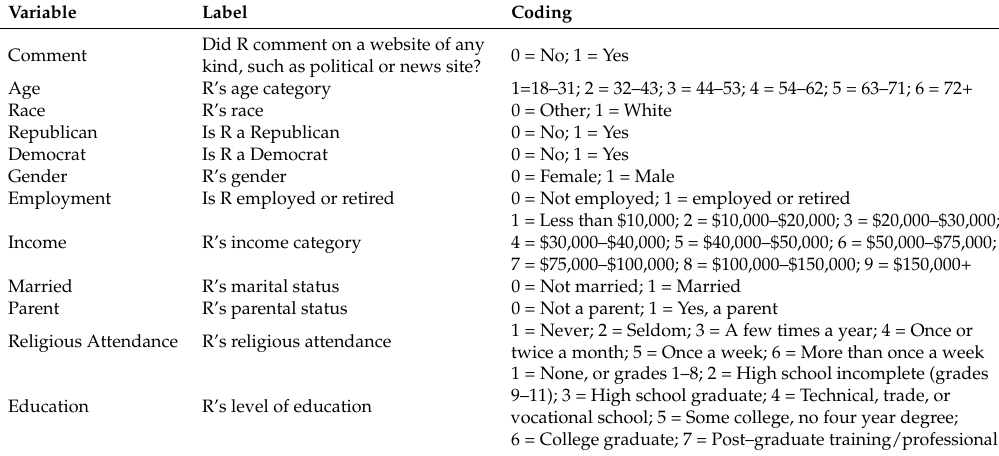
Table A1. Summary of variables used during the 2008 regression analyses.